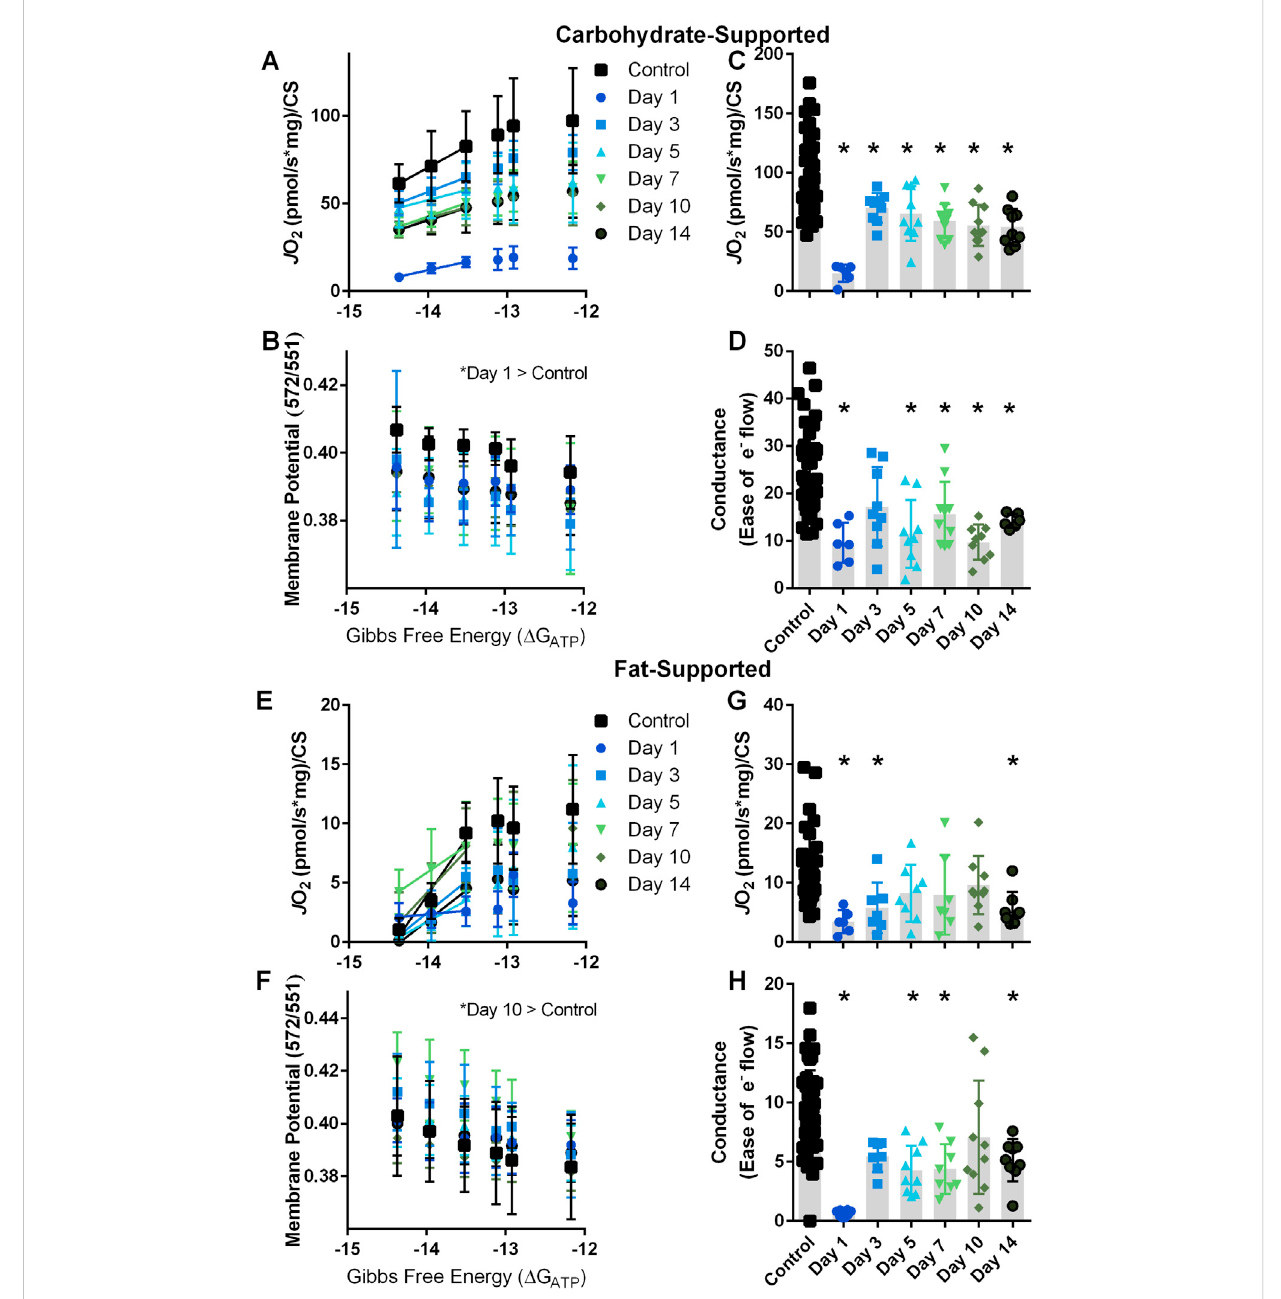
FIGURE 2 Carbohydrate-andfat-supportedrespirationandmitochondrialmembranepotentialatclampedATPGibbsfreeenergystates. (A,B) Carbohydrate- supported JO 2 and mitochondrial membrane potential were measured at decreasing ATP re-synthesis demand Gibbs free energy states in uninjured controlmyo fi bersandmyo fi bersat1,3,5,7,10,and14dayspost-VMLinjury. (C) JO 2 at − 12.17 Δ G ATP . (D) Electronconductancecalculatedbytheslopeof the − 14.37, − 13.96, and − 13.52 Δ G ATP JO 2 rates in panel (A) . (E, F) Fat-supported JO 2 and mitochondrial membrane potential were measured at decreasing ATP re-synthesis demand Gibbs free energy states in uninjured control myo fi bers and myo fi bers at 1, 3, 5, 7, 10, and 14 days post-VML injury. (G) JO 2 at − 12.17 Δ G ATP . (H) Electron conductance calculated by the slope of the − 14.37, − 13.96, and − 13.52 Δ G ATP JO 2 rates in panel (E) . Data are shown as mean ± SD. * indicates statistically signi fi cant difference compared to uninjured control, p < 0.05 analyzed via one-way